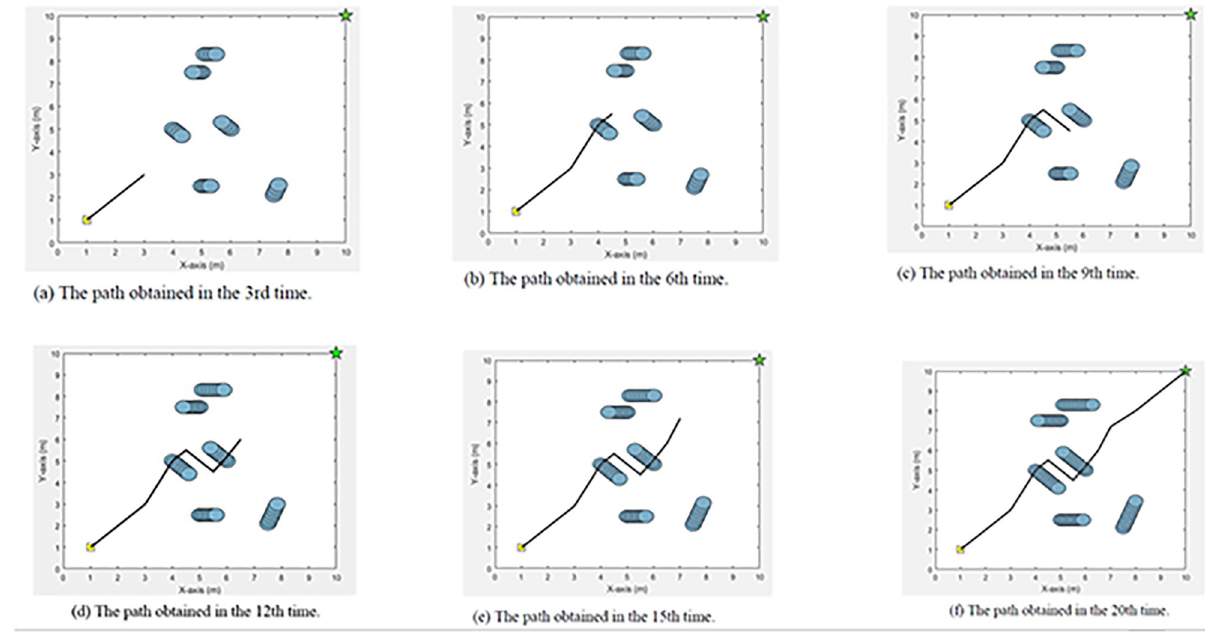
Fig 33. The path obtained from the MOEPSO algorithm in a dynamic